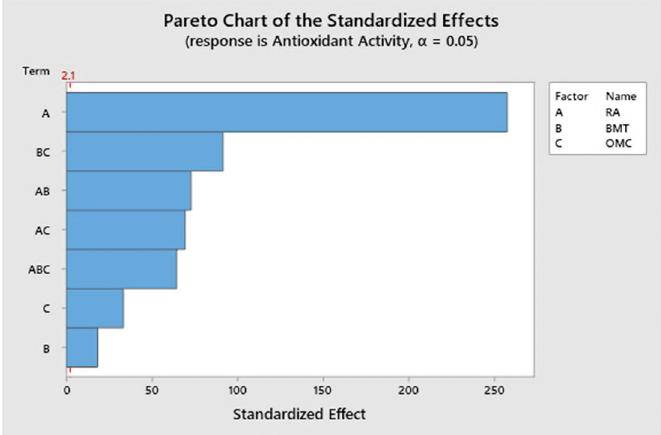
Figure 3. Representation of the effect of isolated and combined variables on the antioxidant activity of formulations (Pareto chart).